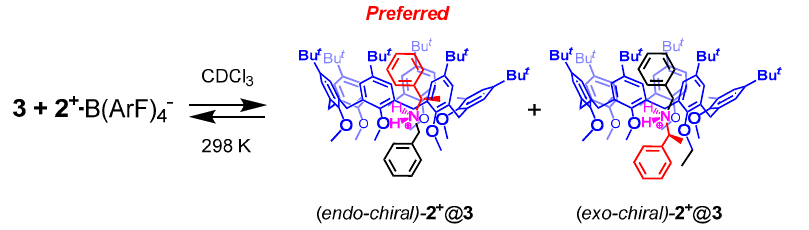
Scheme Scheme 1. Threading equilibrium between hexamethoxycalix[6]arene 3 and ( α -methyl- benzyl)benzylammonium axle 2 + as barfate salt. 1D and 2D NMR analysis of the mixture of 3 and 2 + ·[B(Ar F ) 4 ] − indicated the preferential formation of the ( endo-chiral )- 2 + @ 3 .